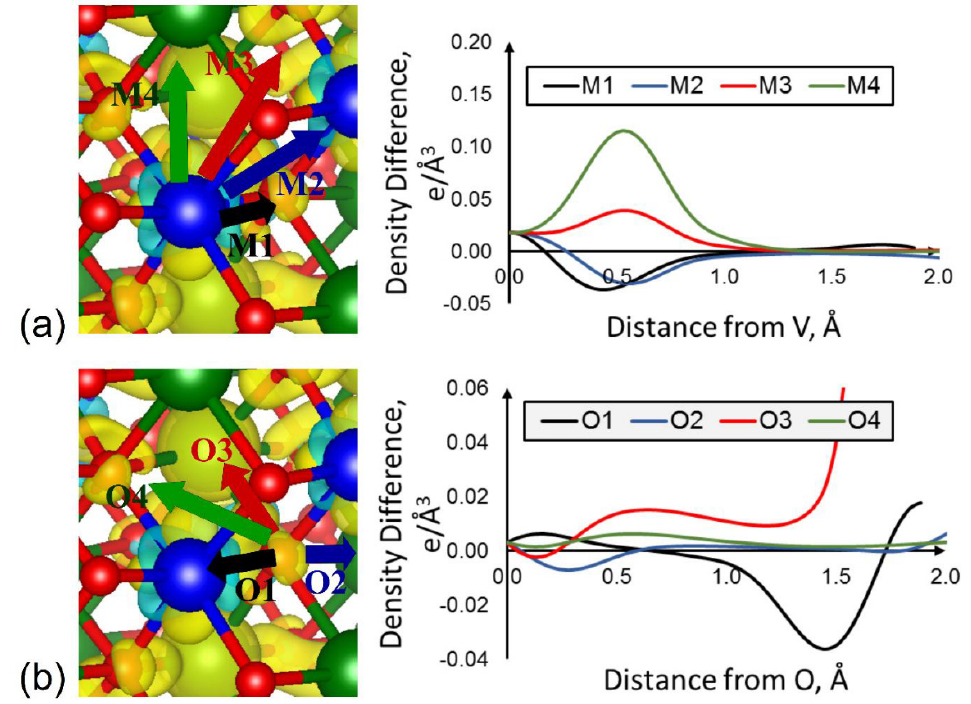
Figure 10. Line profiles (right side) for the charge density difference (left side) between Li2VO3 and LiVO3 around the vanadium ( a ) and oxygen ( b ) centers in different directions. V centers are depicted as blue, oxygen as red, and Li as green spheres. Yellow isosurfaces denote positive, light blue ones negative charge density difference values. Reprinted with permission from Ref. [24]. Copyright 2020 American Chemical Society.